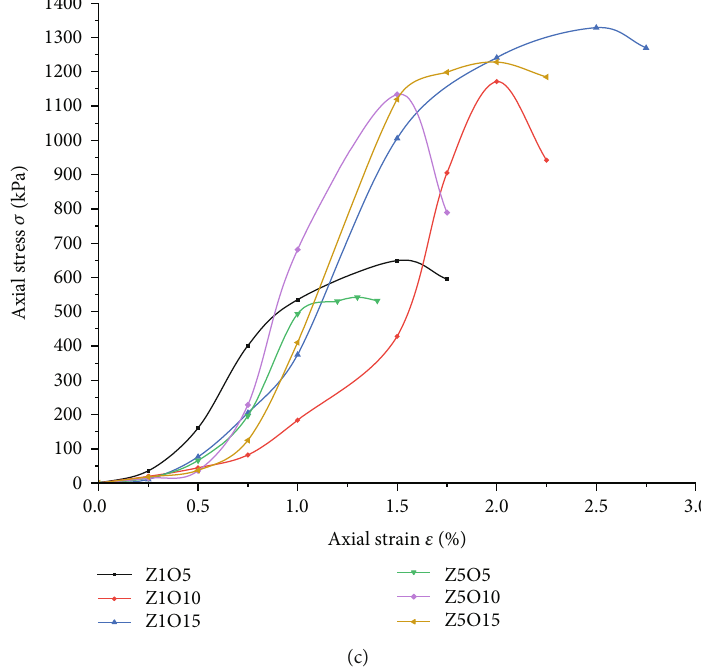
Figure 1: Stress-strain curves of each curing agent. (a) Stress-strain curve of the samples after adding calcium carbonate. (b) Stress-strain curve of the samples after adding calcium hydroxide. (c) Stress-strain curve of the samples after adding calcium oxide.